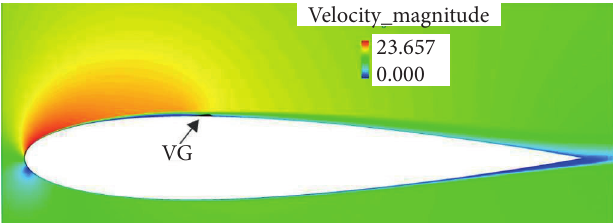
Figure 12. Velocity profile on NACA 0015 airfoil with VG in Plane 3 in Re c = 2.38 × 10 5 and AoA =